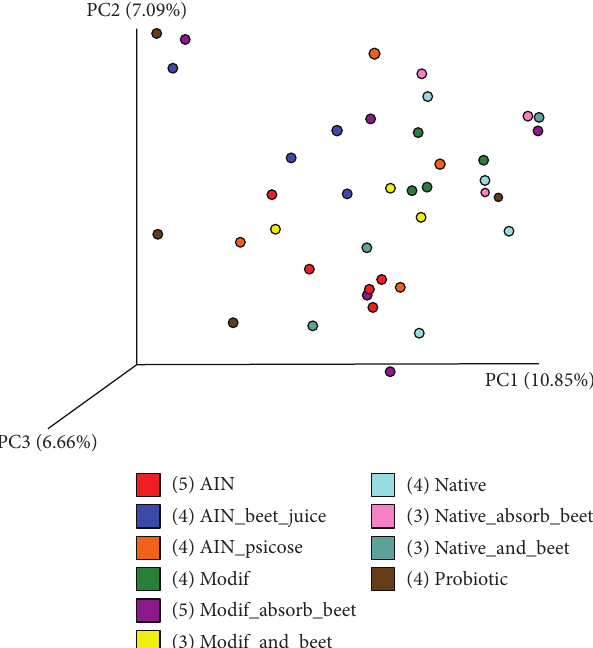
Figure 2: Unweighted principal coordinate analysis of the microbiota composition of the rats after one week of feeding the control (AIN) and 9 different treatments. AIN: control AIN diet; AIN_beet: AIN diet supplemented with beet juice; AIN_Psic: AIN diet supplemented with psicose; Modif: modified taro starch; Mod_absorb_beet: modified taro starch with absorbed beet juice; Modif_and_beet: modified taro starch combined with beet juice by gavage; Native: native taro starch; Nat_absorb_beet: taro starch with absorbed beet juice; Nati- ve_and_beet: native taro starch combined with beet juice by gavage; Probiotic: L.plantarum